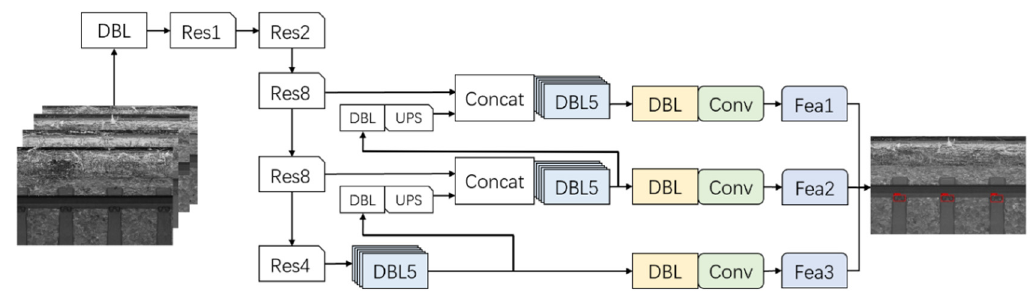
Figure 6. YOLOv3 network structure.